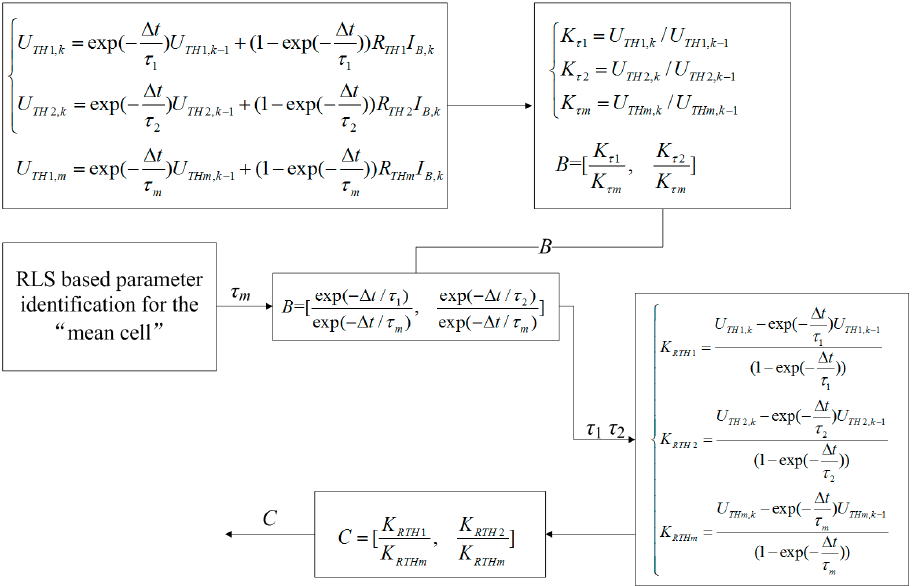
Figure 5. Calculation process of ratio vector B and ratio vector C .